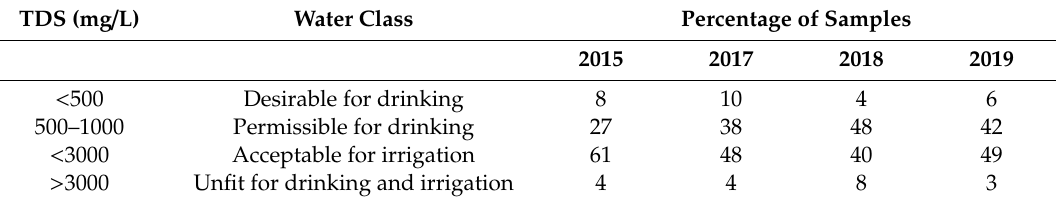
Table 2. Groundwater classification based on TDS values [44]. (TDS = Total Dissolved Solids). TDS (mg /